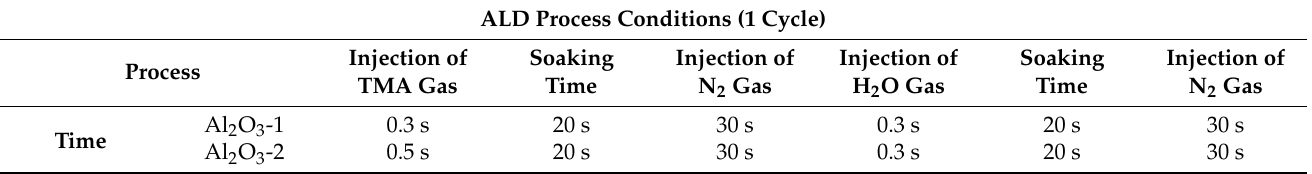
Table 1. Processing times for the different process steps and conditions for the ALD experiment. ALD Process Conditions (1